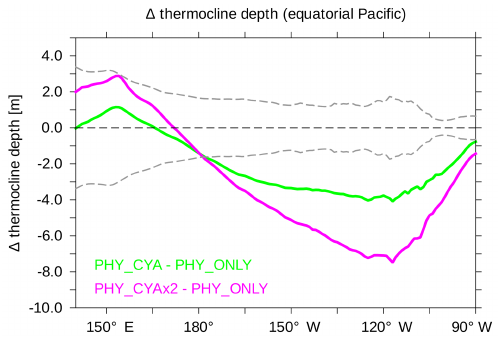
Figure 3. Difference in the climatological mean thermocline depth (m) between PHY_CYA and PHY_ONLY (green) and PHY_CYAx2 and PHY_ONLY (purple). To provide a sense for the internal variability in the model, the grey dashed lines show ± 2 times the standard deviation of eight 100-year periods of CTRL.